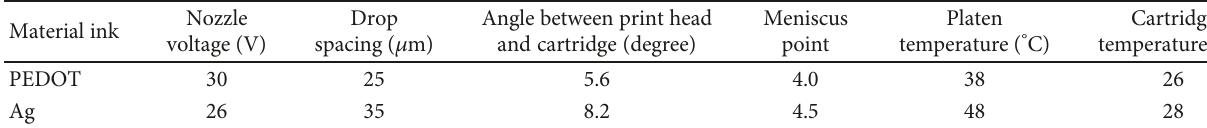
Figure 1: Surface treatment e ff ect on PEDOT printing: (a) without surface treatment and (b) with surface treatment (5 mm × 5 mm pattern). Table 3: Set parameters during the printing of each type of material.